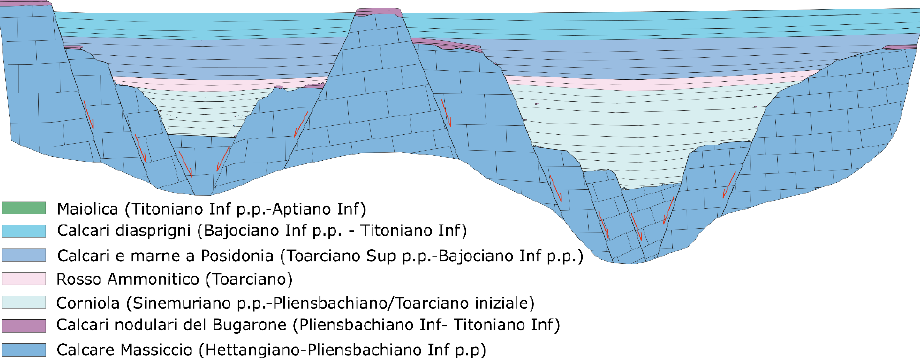
Figure 8. A schematic geological section used for animated modeling of the Jurassic paleoenviron- ment. During the animation, the activation of normal faults and the prosecution of sedimentation are shown.